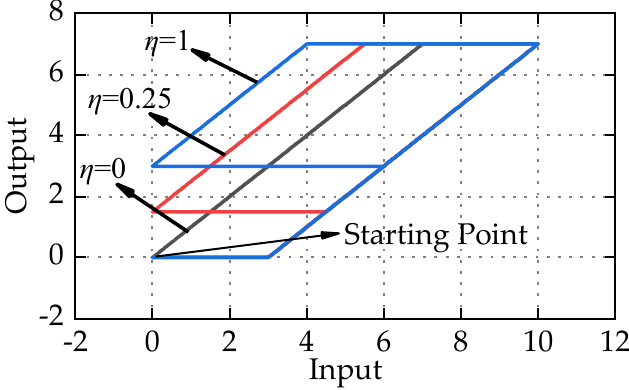
ff erent delay coe ffi cient η